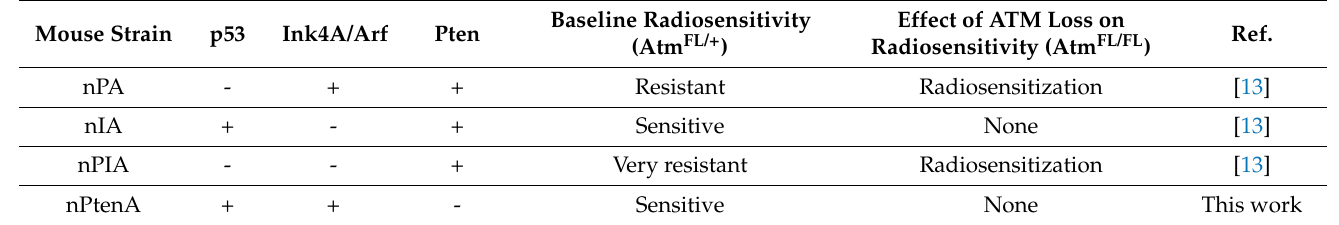
Table 2. Summary of the effects of ATM loss on radiosensitivity in primary mouse brainstem glioma models of different